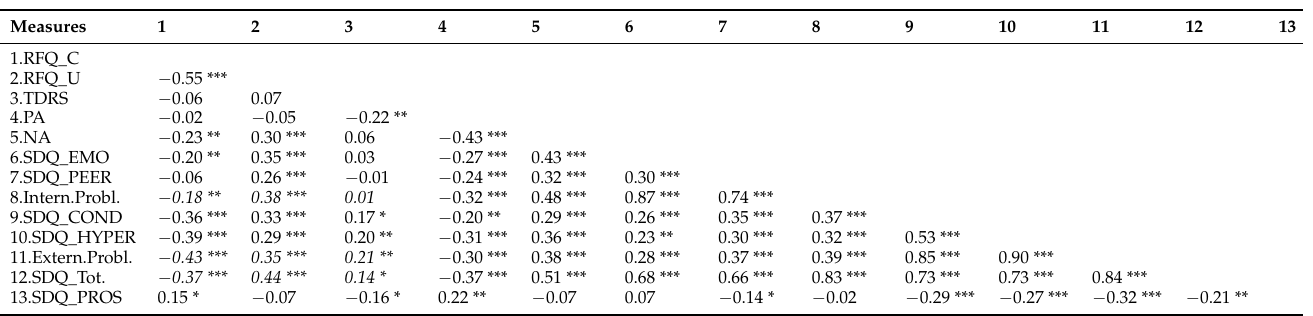
Table 5. Correlations between all measures (comparison group, n = 210).